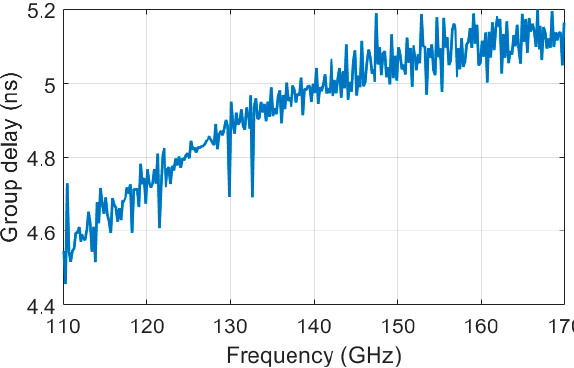
Figure 14. Measured reflection loss and transmission loss of the fiber that was used during the measurements.